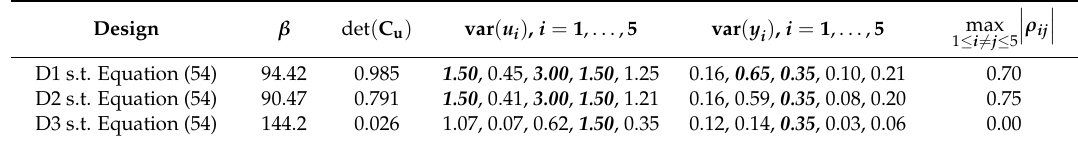
Table 6. FCC reactor-regenerator system. Results for different experiment designs. GBN signals in D3 are based on switching probability, p sw = 0.025, and mean switching time, E [ T sw ] = 40 min. Active constraints are shown in bold